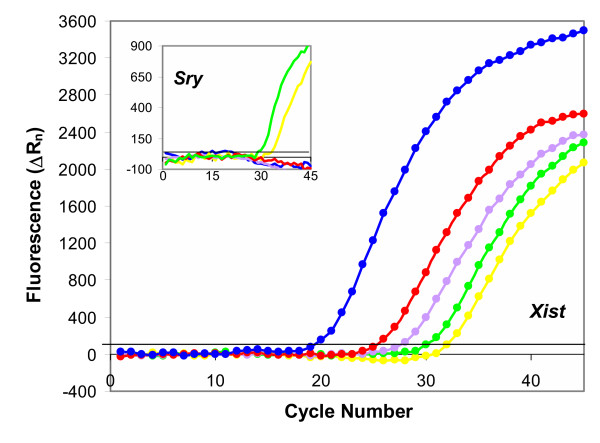
Accuracy and efficiency of the PurAmp protocol for wide-range copy number quantification. Xist real-time PCR plots generated from individual embryos or cells processed with the PurAmp method. In the samples analyzed, the number of Xist genomic DNA + cDNA (RNA) templates increased right-to-left from 3 (yellow) to 10,000 (blue), as detailed in the Results section. Yellow, 3-cell male embryo; green, 4-cell male embryo; light purple, single blastomere from a 4-cell female embryo; red, 4-cell female embryo; blue, female blastocyst. Male samples also produced an Sry signal (inset), confirming sex assignment based on the presence or absence of Xist expression.